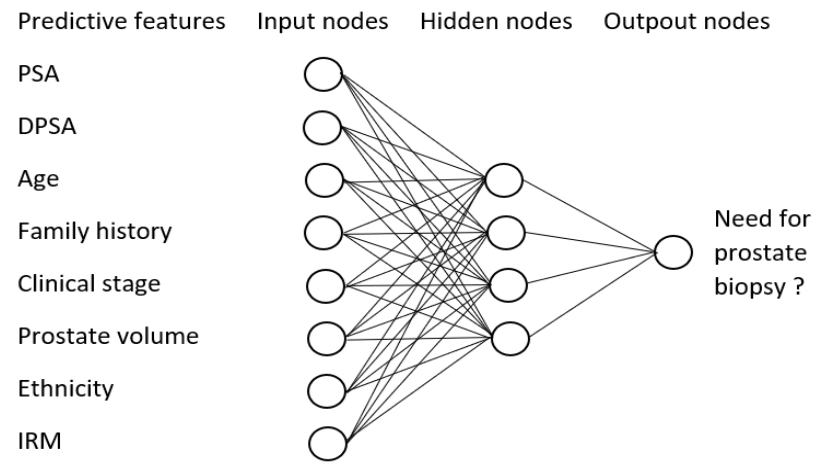
Figure 1. Artificial Neural Network model based on prostate cancer biopsies.